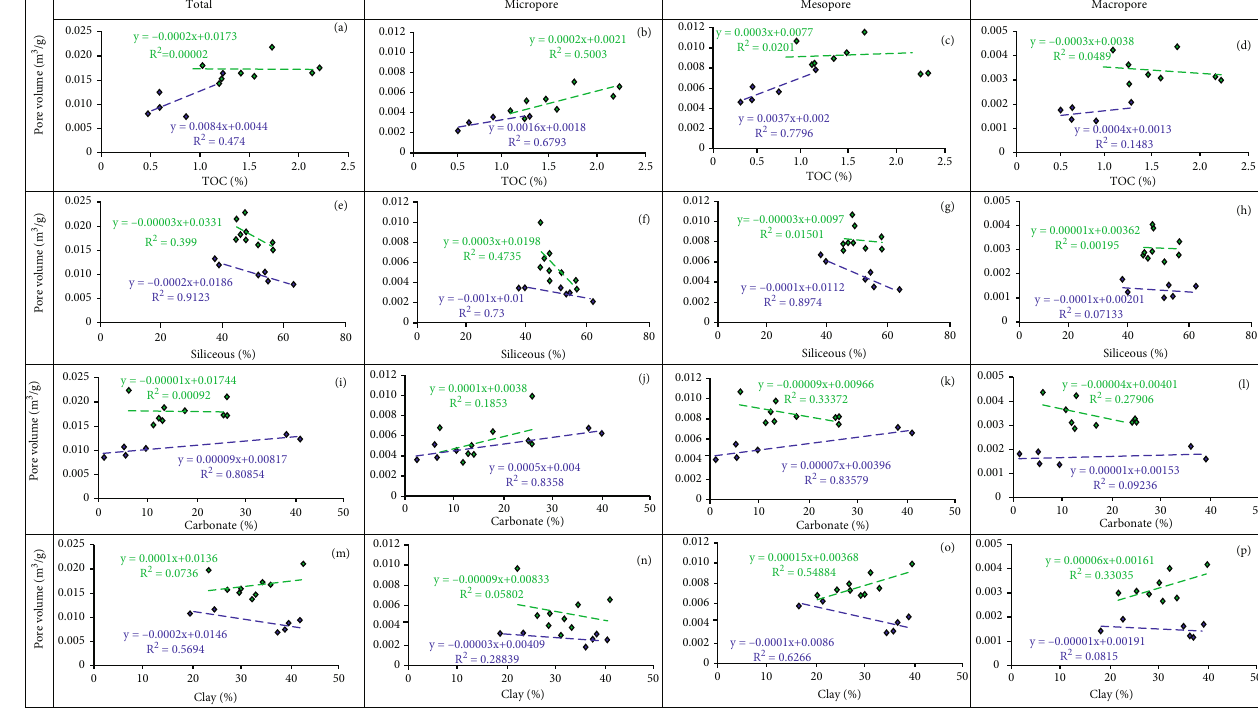
Figure 9: Correlation between shale material composition and pore